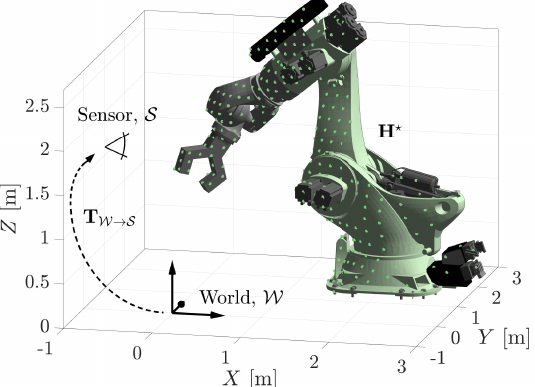
Figure 14. The maximum sum of evidence estimate, H (cid:63) , of a 6-DOF robot’s configuration.